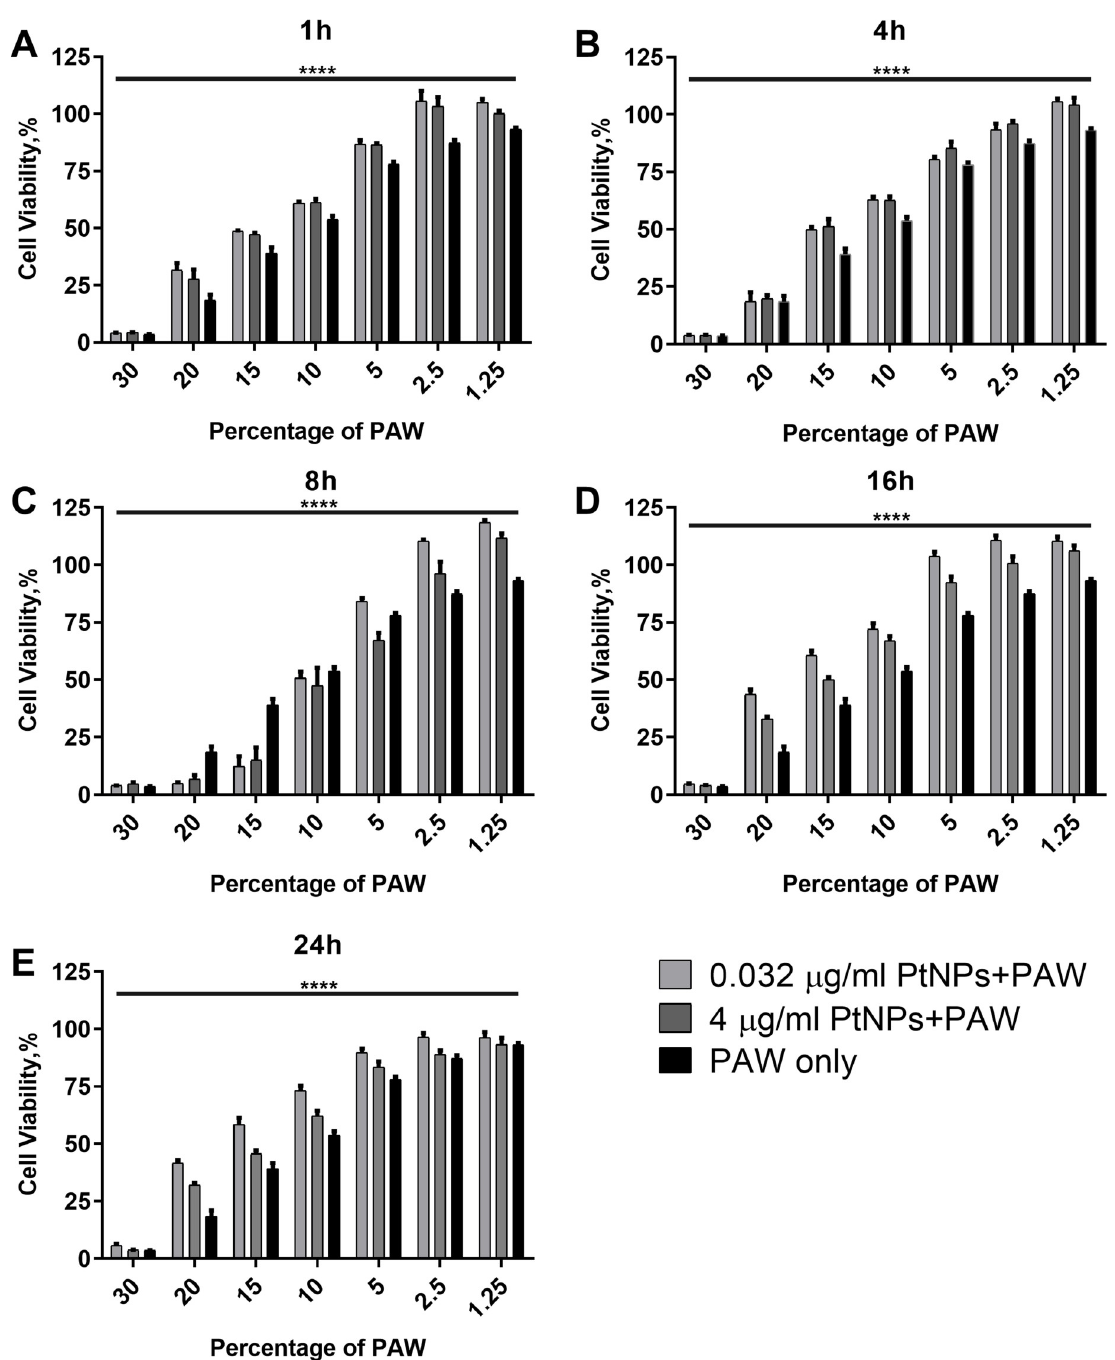
Fig 7. Dose responses for PtNPs treatment. U-251 MG cells were incubated with 0.032 and 4 μ g/ml PtNPs for 1h (A) , 4h (B) , 8h (C) , 16h (D) , and 24h (E) then treated with increasing concentrations (0 � 30%) of PAW. Alamar blue cell viability assay was carried out 48 h after PAW